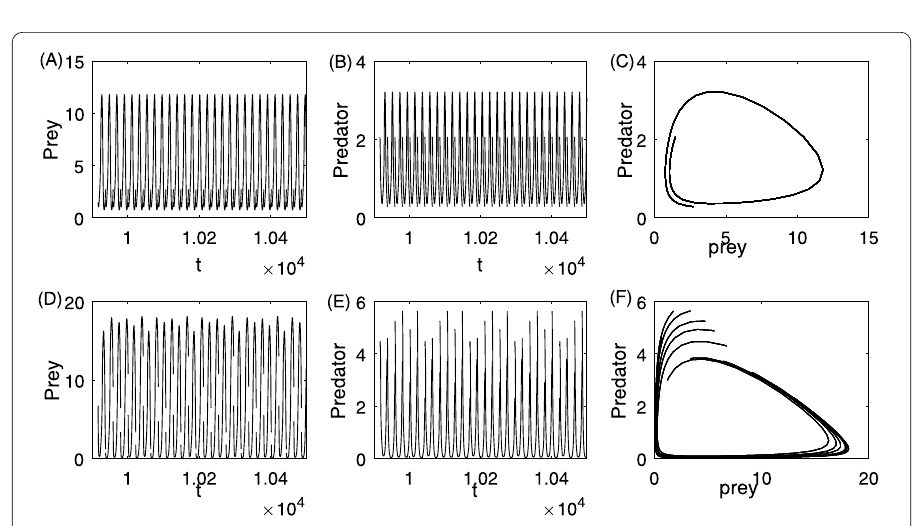
Figure 5 Two coexisting attractors of model (17) with T = 21.1. The other parameter values are identical to those in Fig. 4. The initial conditions are: ( A – C )( x 0 , x 0 ) = (1,0.5);( D – F )( x 0 , x 0 ) =